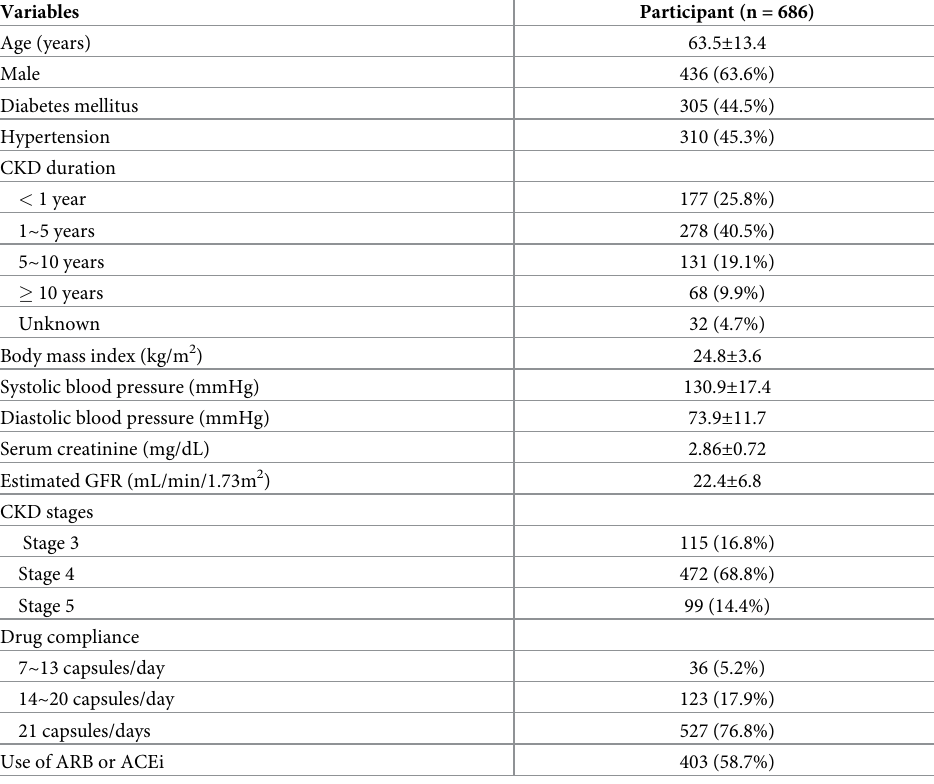
Table 1. Demographic and baseline clinical characteristics of ITT